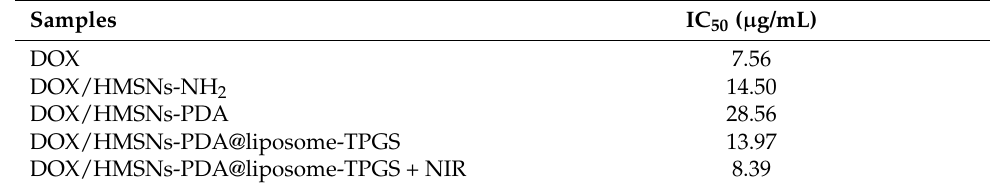
Table 3. IC 50 values of DOX and DOX-loaded nanoparticles.